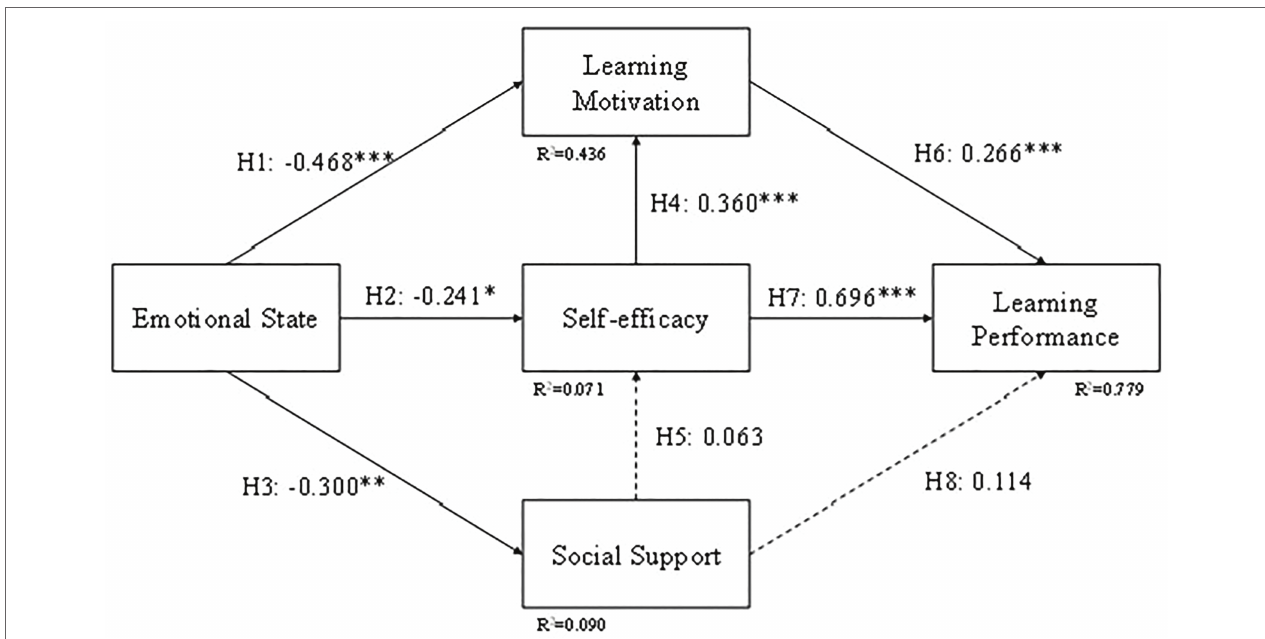
FIGURE 9 | Model result for EG1. * p < 0.05; ** p < 0.01; *** p <